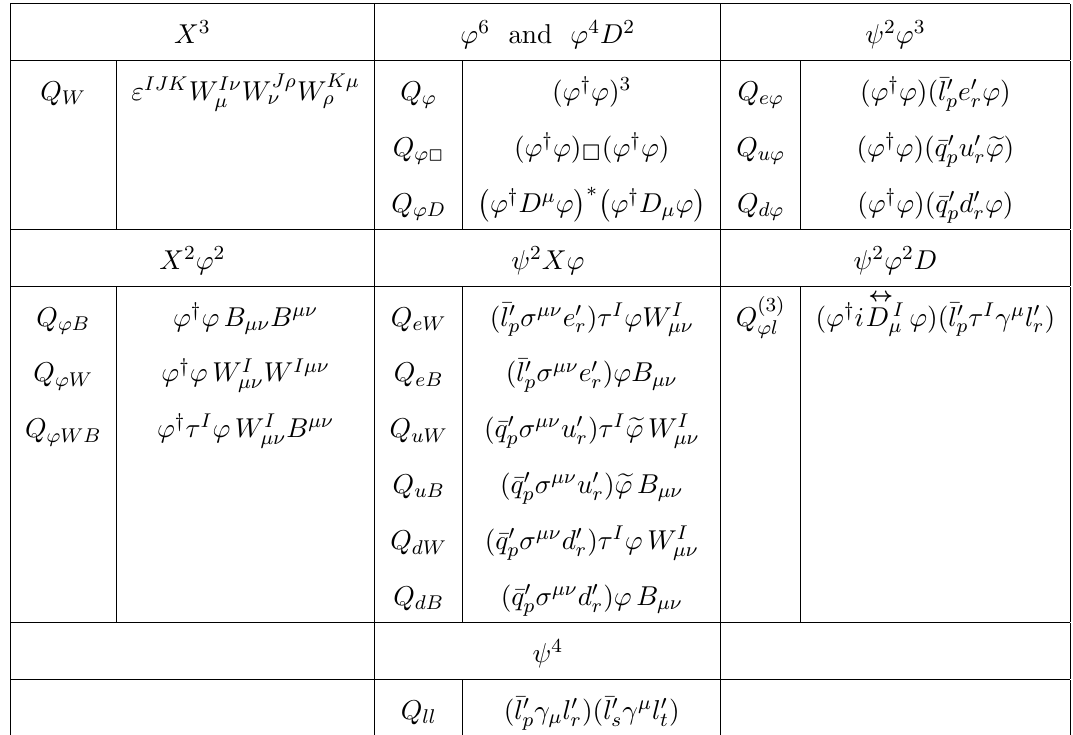
Table 1 . A set of d = 6 operators in Warsaw basis that contribute to the h directly or indirectly, in R (cid:24) -gauges. We consider only CP-conserving operators in our analysis. The operator Q ’ cancels out completely in the h present themselves indirectly through the translation of the renormalised vacuum expectation value (vev) into the well measured Fermi coupling constant, cf. eq. (3.5). The notation is the same as